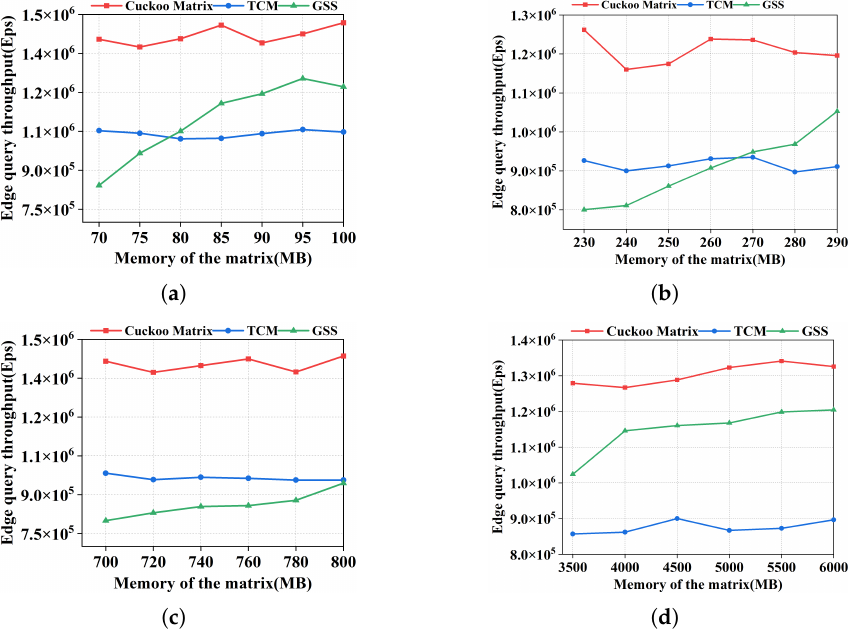
Figure 5. Throughput of edge queries. ( a ) Skitter. ( b ) DBLP. ( c ) Orkut. ( d )